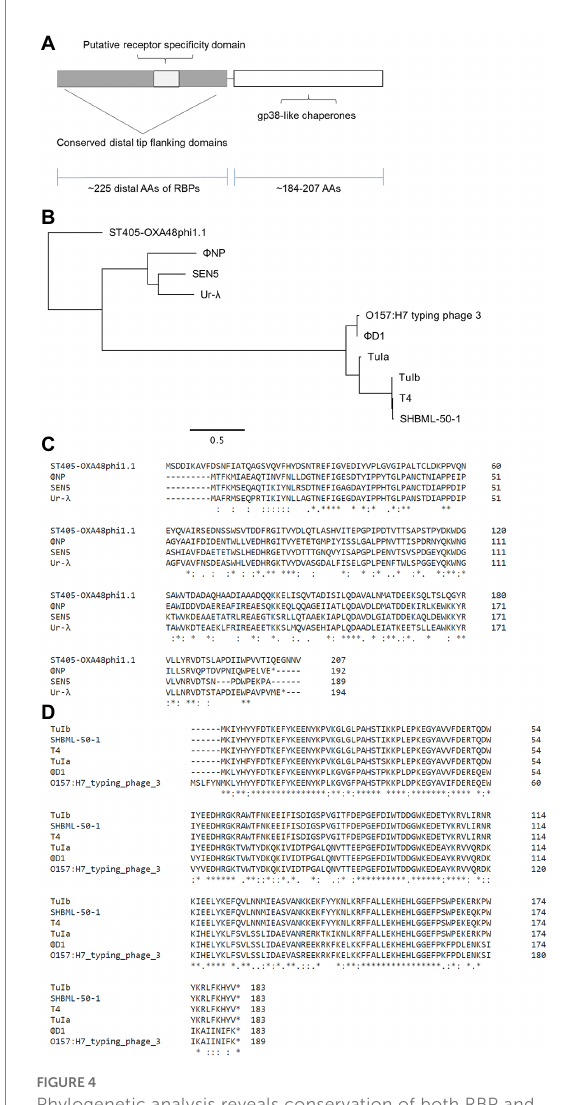
FIGURE 4 Phylogenetic analysis reveals conservation of both RBP and RBP assembly proteins within the newly identified enteric RBP family. (A,B) Amino acid (AA) alignment by ClustalOmega depicting high similarity between downstream structural ORF5 of Φ NP, the known tail fiber assembly chaperone protein of T4 (gp38; downstream of gp37), and uncharacterized structural proteins adject to the putative RBPs of TuIa, TuIb, Klebsiella pneumoniae phage ST405- OXA-48phi1.1, the E. coli O157:H7 typing phage 3, Yersinia pestis phage Φ D1, the Salmonella spp. phage SEN5, and the Shigella spp. phage SHBML-50-1. When aligned, two clear families emerged: one containing Φ NP, SEN5, Ur- λ , and ST405-OXA-48phi1.1 (A) and a more recently evolved family containing T4, TuIa, TuIb, the O157:H7 typing phage 3, Φ D1, and SHBML-50-1 (B) . (C) Maximum likelihood tree of